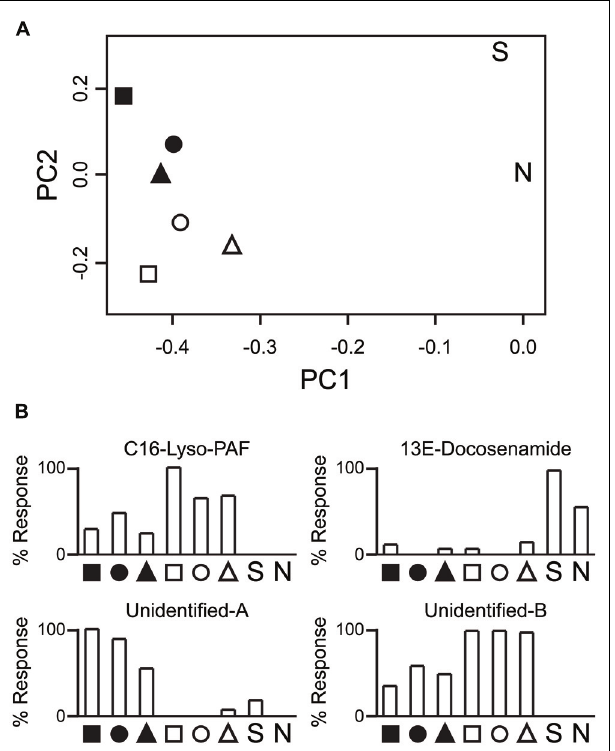
FIGURE 4 | Preliminary analysis of the Astrangia poculata– Symbiodinium psygmophilum metabolome. (A) Principle component analysis of metabolite profiles. Shown are principle components 1 and 2 (x- and y-axis, respectively) of Pareto-transformed metabolite data. Shapes indicate host genotype ( n = 3). Black fills correspond to symbiont-rich polyps.White fills correspond to nearly symbiont-free polyps. “S” indicates a sample of a Symbiodinium psygmophilum monoculture. “N” indicates a negative control (purified water). Astrangia poculata samples cluster by the symbiotic state of the polyps rather than by host genotype. (B) Repre- sentative profiles for specific metabolites. C16-Lyso-PAF was abundant in non-symbiotic polyps but low in symbiotic polyps and absent in Symbiodinium culture. 13E-Docosenamide was mainly present in Symbiodinium culture but not in coral tissue.The two unidentified compounds are characteristic of metabolites with greater detection in symbiotic (Unidentified-A) or non-symbiotic (Unidentified-B) polyps. Polato etal. (unpublished